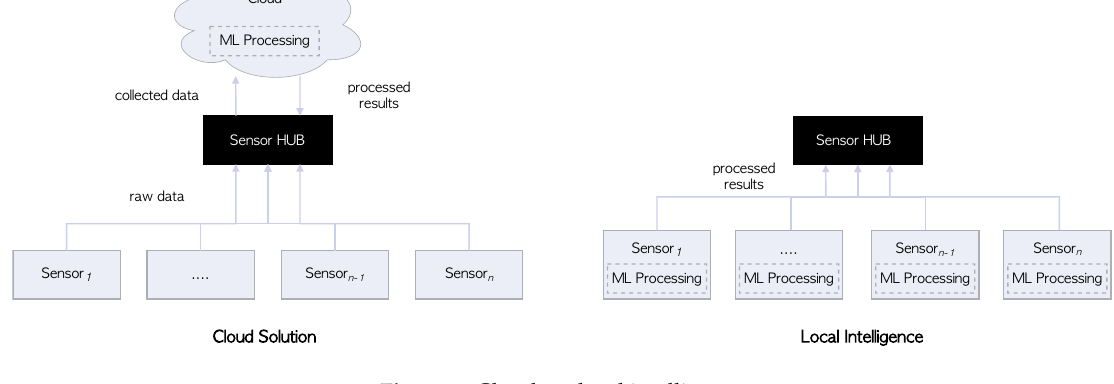
Figure 5. Cloud vs. local